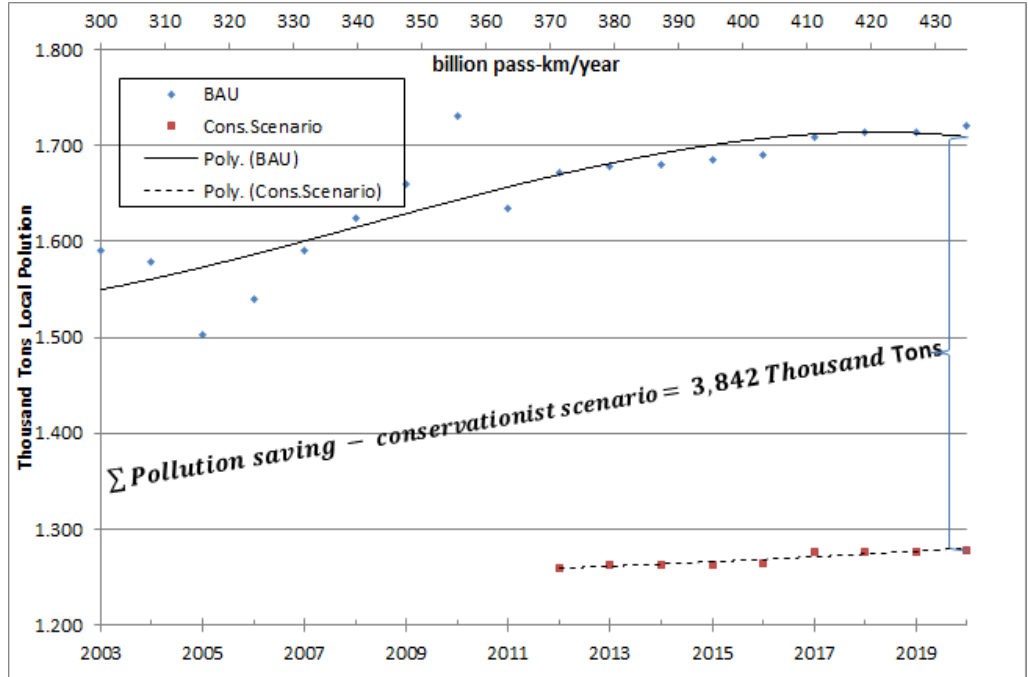
Figure 10. Emission Trends for Local Pollutants–Passenger